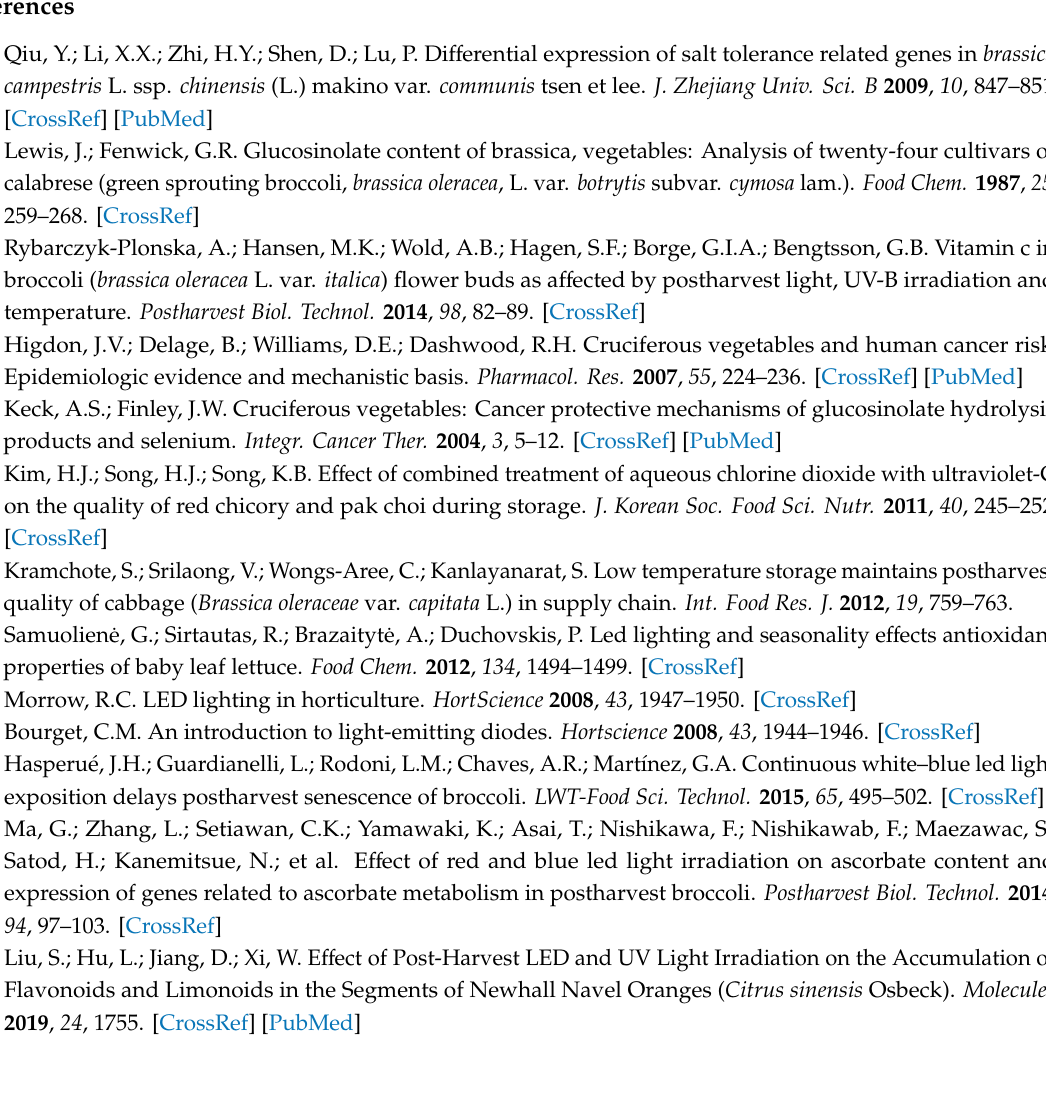
Figure S1: The heatmap of di ff erentially expressed genes identified in dark-stored control 5d (T04, T05, T06), LED treatment 5d (T07, T08, T09) (FC ≥ 2; FDR ≤ 0.01). Table S1: Known genes identified in pak-choi.; Table S2: The di ff erentially expressed genes identified in initial (T01, T02, T03), dark-stored control 5d (T04, T05, T06), LED treatment 5d (T07, T08, T09) (FC ≥ 2; FDR ≤ 0.01); Table S3: The di ff erentially expressed genes identified in dark-stored control 5d (T04, T05, T06), LED treatment 5d (T07, T08, T09) (FC ≥ 2; FDR ≤ 0.01); Table S4: Target genes of the nat-siRNAs involved in Photosynthesis; Table S5: Target genes of the nat-siRNAs involved in porphyrin and chlorophyll metabolism; Table S6: Target genes of the nat-siRNAs involved in Glucosinolate